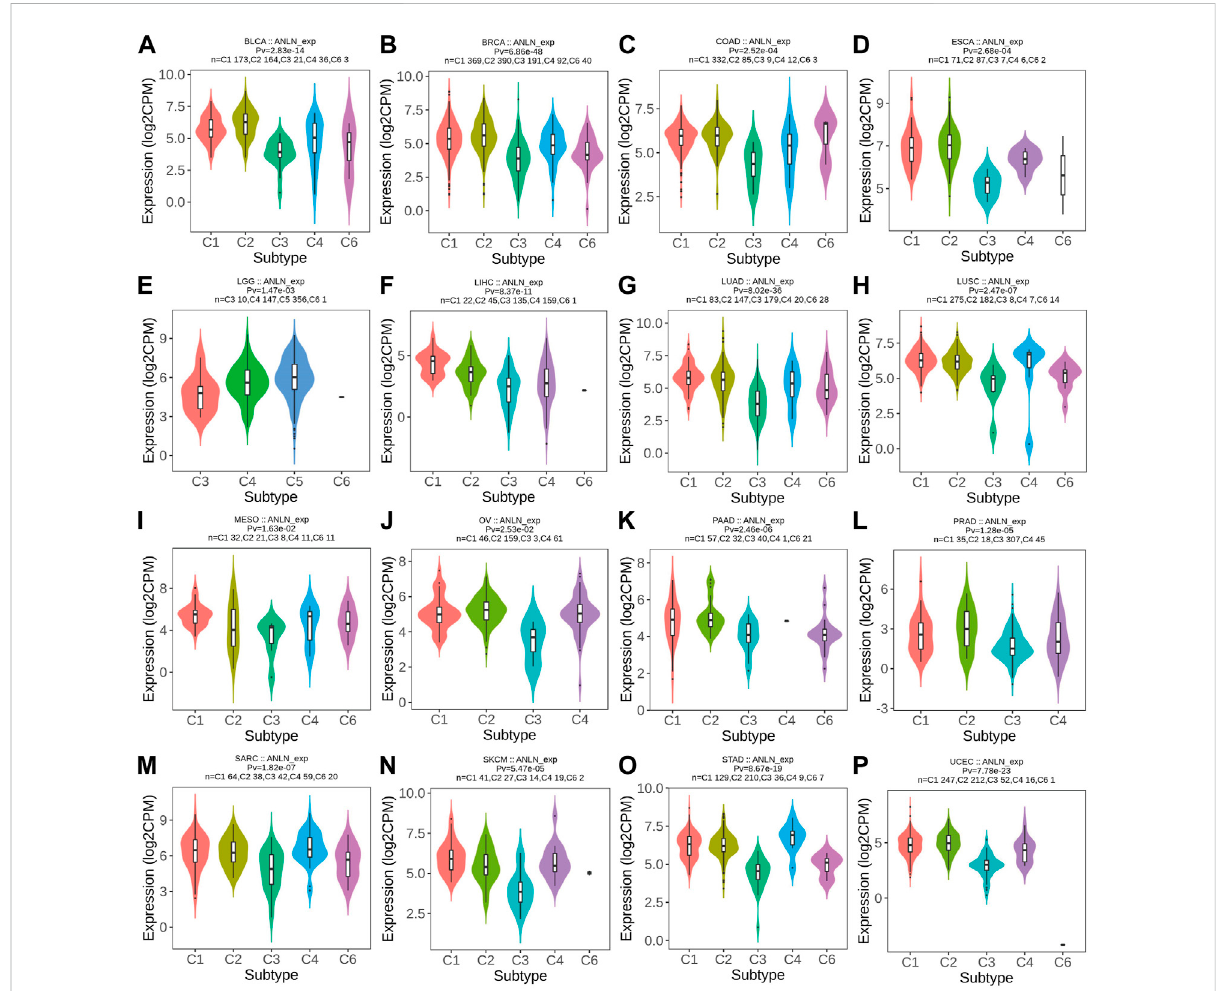
FIGURE 11 CorrelationsbetweenimmunesubtypesandANLNexpressionacrossTCGAtumors. (A) BLCA; (B) BRCA; (C) COAD; (D) ESCA; (E) LGG; (F) LIHC; (G) LUAD; (H) LUSC; (I) MESO; (J) OV; (K) PAAD; (L) PRAD; (M) SARC; (N) SKCM; (O) STAD; (P) UCEC. C1 (wound healing), C2 (IFN-g dominant), C3 (in fl ammatory), C4 (lymphocyte deplete), C5 (immunologically quiet), and C6 (TGF-b